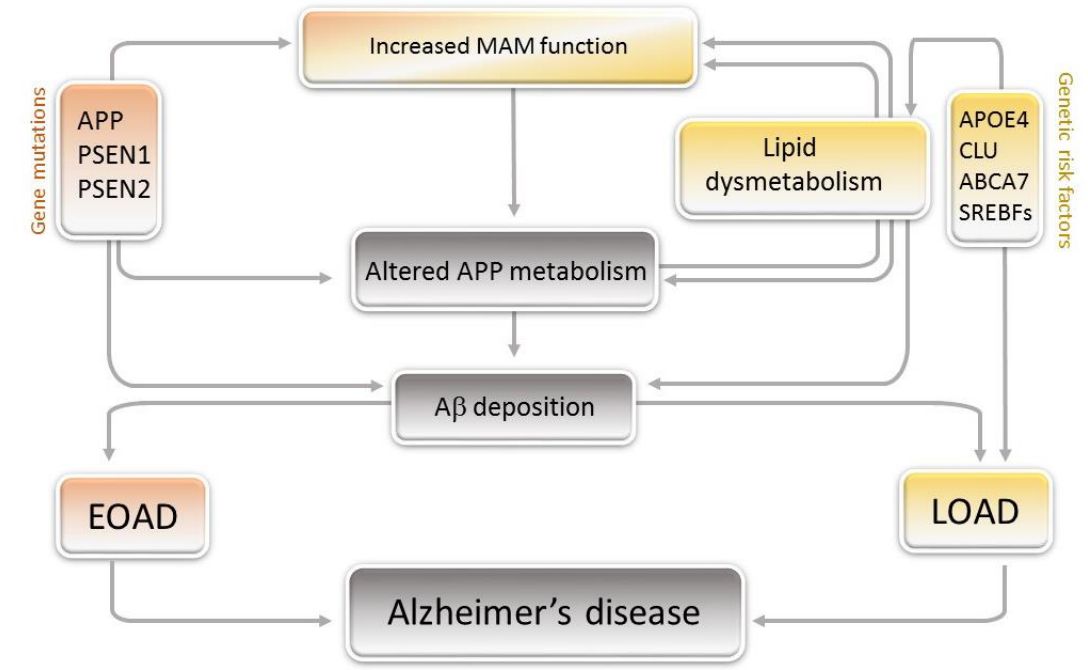
Figure 1. Gene mutations and genetic risk factors linked to lipid dysmetabolism and the progression of Alzheimer’s disease (AD). Gene mutations responsible for inherited early-onset AD cases (EOAD, gene mutations) and genetic risk factors for late-onset AD cases (LOAD, genetic risk factors) lead to altered amyloid precursor protein (APP) processing and brain amyloid-β (Aβ) deposition. Disruption of lipid homeostasis induces abnormal lipid composition in rafts and increased mitochondria-associated endoplasmic reticulum membrane (MAM) function in which targeted APP is proteolytically processed into Aβ by presenilins (PSEN). Conversely, cleavage of APP directly affects cellular lipid composition by altering the synthesis of several lipids that are enriched in lipid rafts. Abbreviations: APOE4 (Apolipoprotein E4); CLU (Clusterin); ABCA7 (ATP-binding cassette sub-family A member 7); SREBFs (Sterol regulatory element-binding genes).